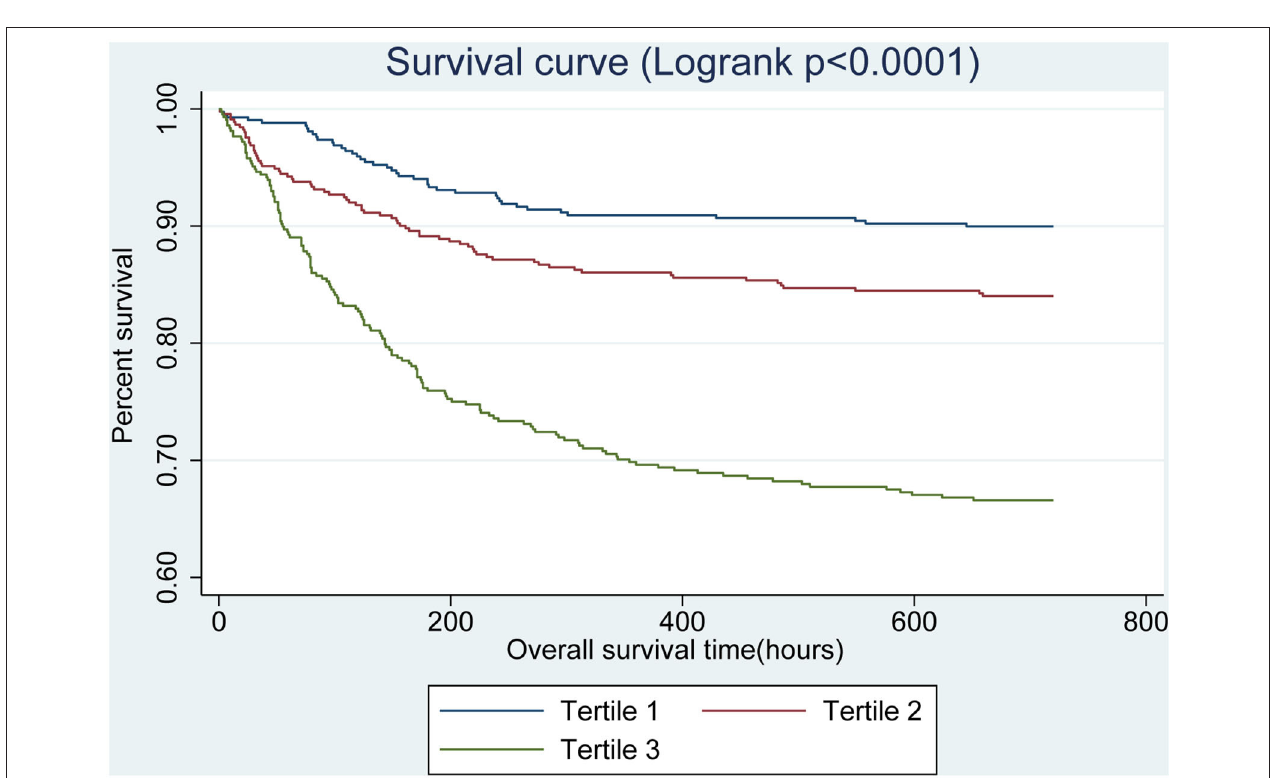
FIGURE 3 | Kaplan–Meier survival curves for critically ill patients with SAH based on tertile of admission BG. x-Axis: survival time (h). y-Axis: cumulative survival probability. SAH, subarachnoid hemorrhage. BG, blood glucose. invasiveness, continuous glucose monitoring is still a challenging technology to use in a large epidemiological setting